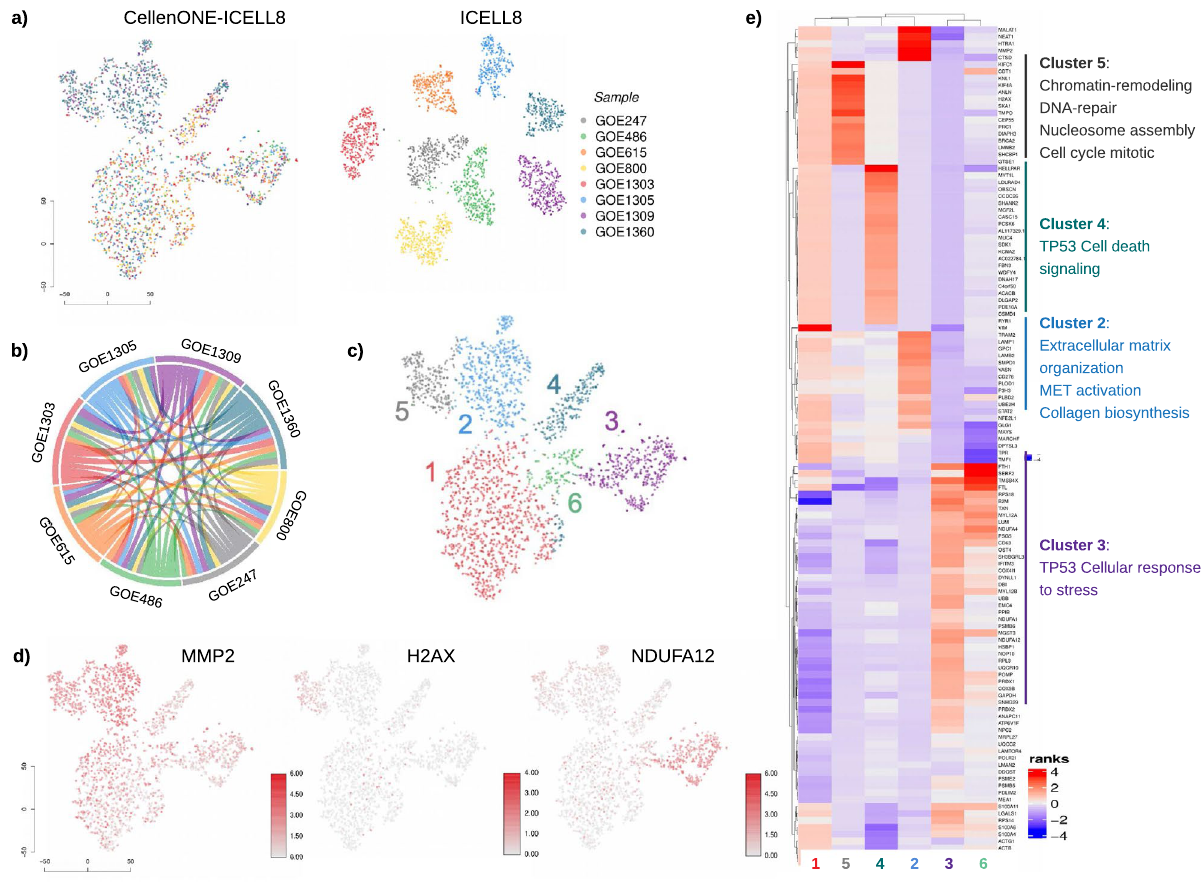
Figure 4. Analysis of transcriptional heterogeneity of dermal fibroblast derived from patients using the novel platform. ( a ) t-SNE of the ICELL8 and CellenONE-ICELL8 experiments. ( b ) Circo plot showing connection of top 100 marker genes of the samples in both ICELL8 and CellenONE-ICELL8 platforms. ( c ) Unsupervised t-SNE of the CellenONE-ICELL8 approach. ( d ) t-SNE showing most prominent markers for different clusters. ( e ) Heatmap of rank scores of the top 30 markers in each unsupervised cluster, including enriched